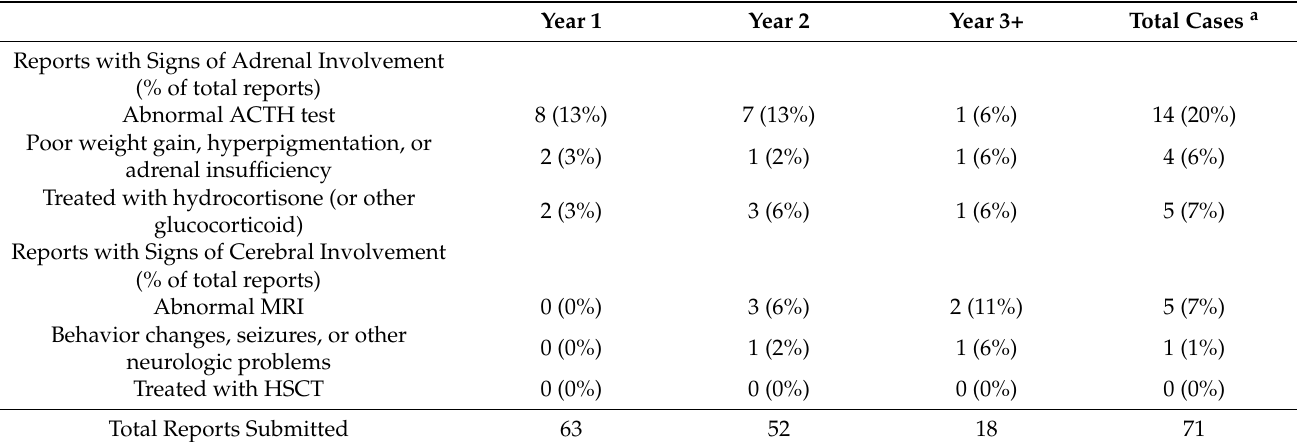
Table 3. Long term follow-up ALD clinical findings,